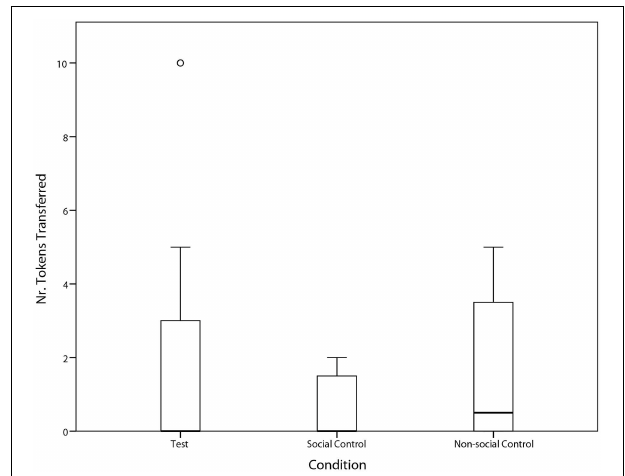
FIGURE 3 | Median ± Quartiles and 95% confidence intervals of the number of tokens transferred from subject to partner in Test-, Social Control, and Non-Social Control